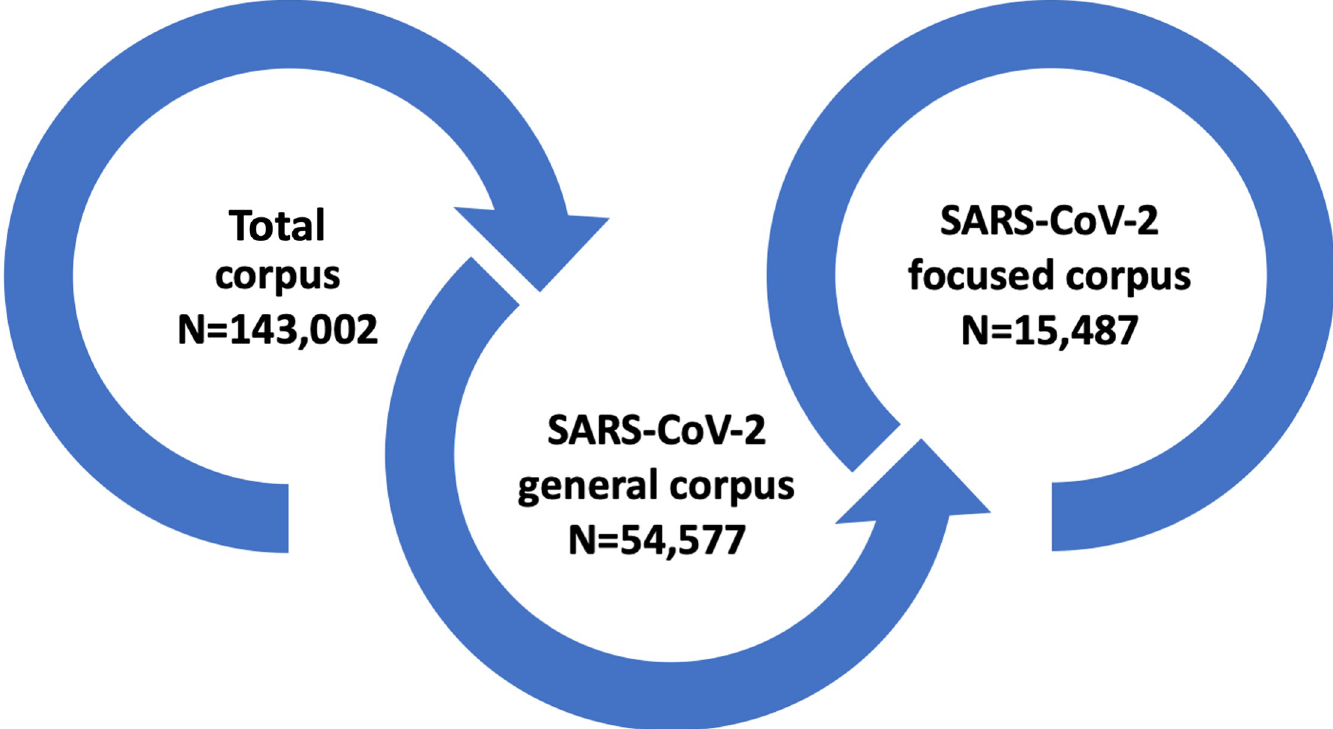
Fig 1. The process for the composition of the three nested corpora considered within the present study.